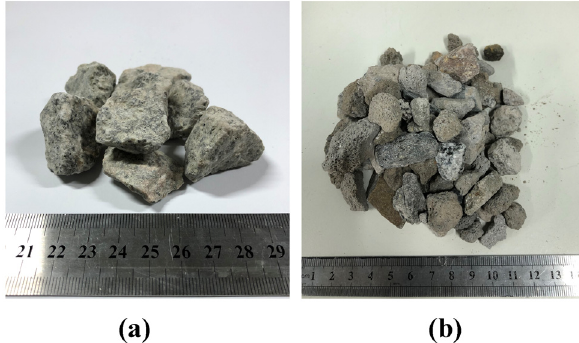
Table 3: Mix proportion of RAC ( kg · m − 3